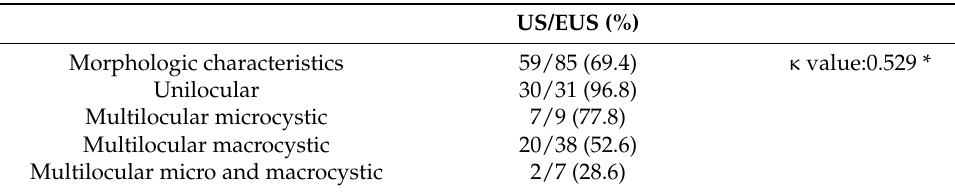
Table 3. Capability of US to characterize the locularity and the size of individual compartments of PCLs as a reference standard using EUS. US/EUS (%) Morphologic characteristics 59/85 (69.4) κ value:0.529 * Unilocular 30/31 (96.8) Multilocular microcystic 7/9 (77.8) Multilocular macrocystic 20/38 (52.6) Multilocular micro and macrocystic 2/7 (28.6) US, ultrasonography; PCL, pancreatic cystic lesion; EUS, endoscopic ultrasonography. * κ value (strength of agreement): 0.81–1.00, excellent; 0.61–0.81, good; 0.41–0.60, moderate; 0,21–0.40, fair; 0–0.20, poor.